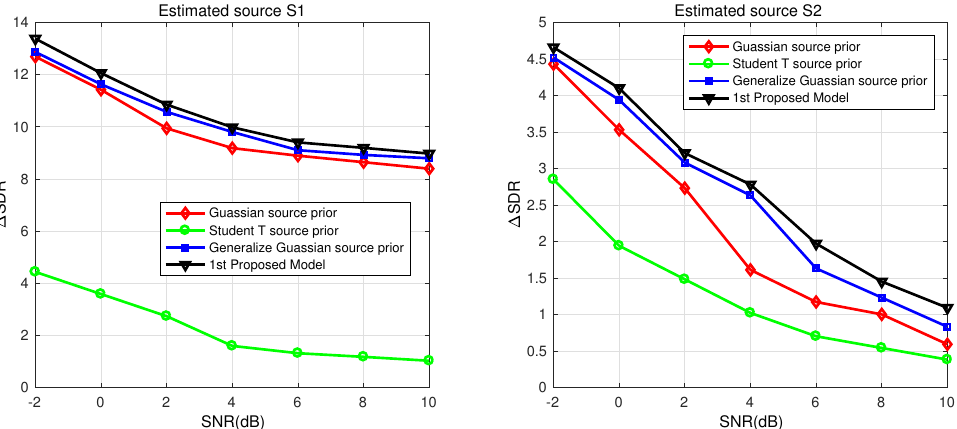
Figure 3. Change in SDR for convolutive pink noisy mixture with variable SNR for the first proposed